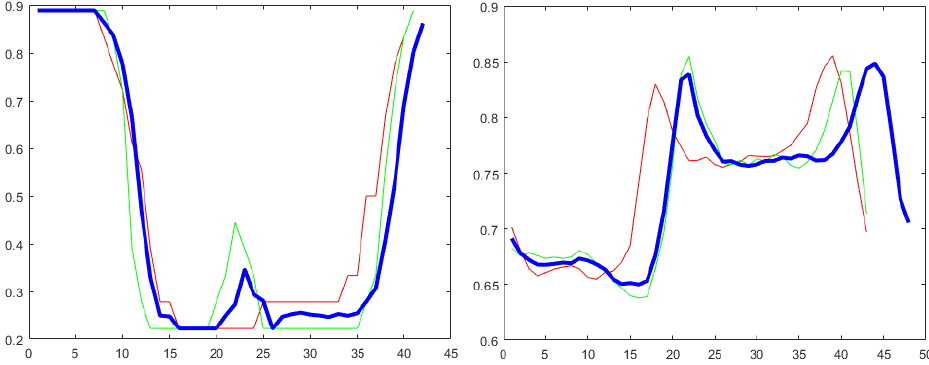
Figure 4. Time series generated by ARSPAWNER (blue curve) based on two exemplary timeseries (red and green curves). The left plot represents “draw circle” action and the right plot represents “high arm wave” action from MSRA II dataset.